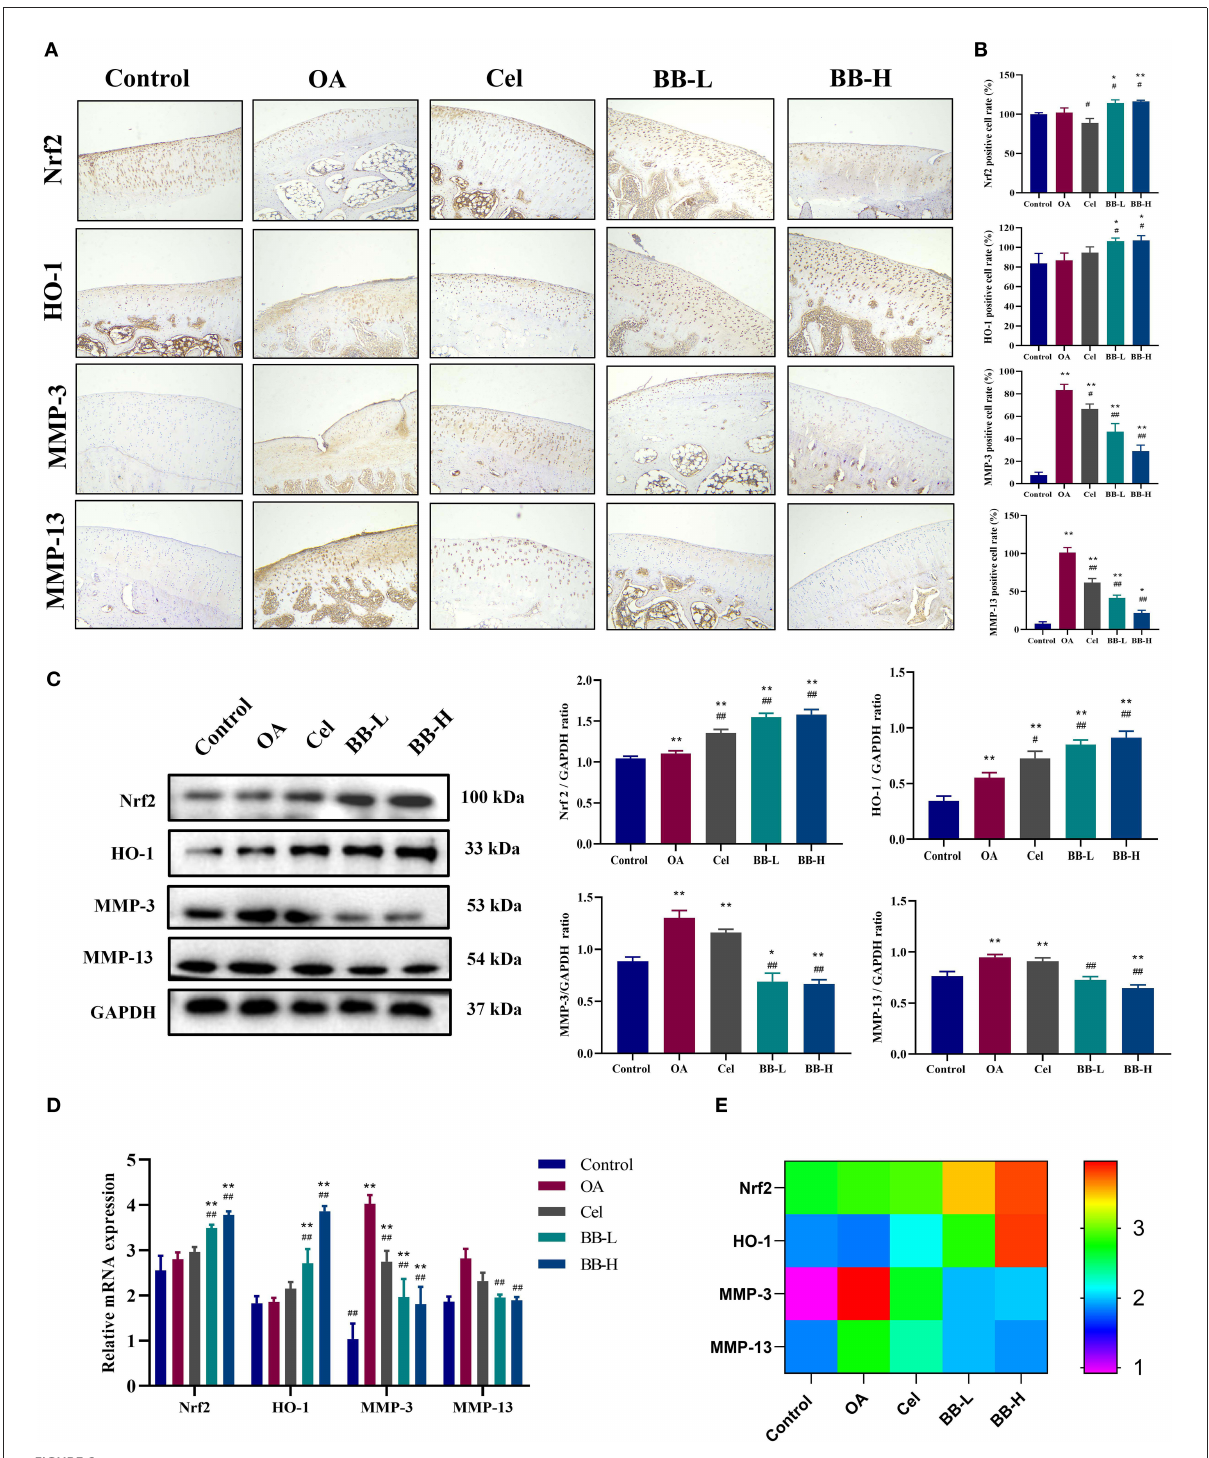
FIGURE6 Bilobalide inhibits the production of matrix degrading proteins MMP-3 and MMP-13, via Nrf2/HO-1. (A) Representative images of immunohistochemical staining for Nrf2, HO-1, MMP-3 (200 × ), and MMP-13 proteins in rabbit cartilage in each group. (B) Percentage of positive cells after eight weeks of treatment. (C) Assessment and quantification of Nrf2, HO-1, MMP-3, and MMP-13 protein levels in cartilage by western blotting. (D,E) The expression of Nrf2, HO-1, MMP-3, and MMP-13 mRNA in rabbit cartilage tissue by qRT-PCR. All data are presented as mean ± SD ( n = 3). * p < 0.05 and ** p < 0.01 vs. control group; # p < 0.05 and ## p < 0.01 vs. OA